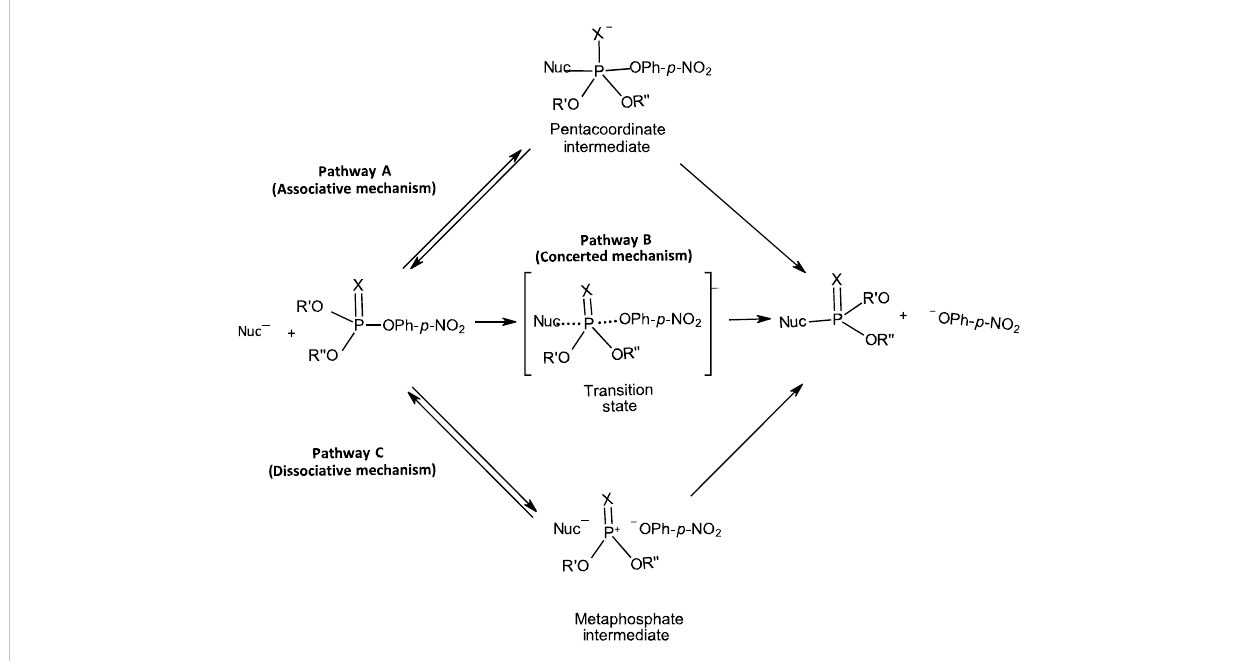
FIGURE 1 The three possible mechanisms for the reactions of nucleophiles with organophosphorus esters.